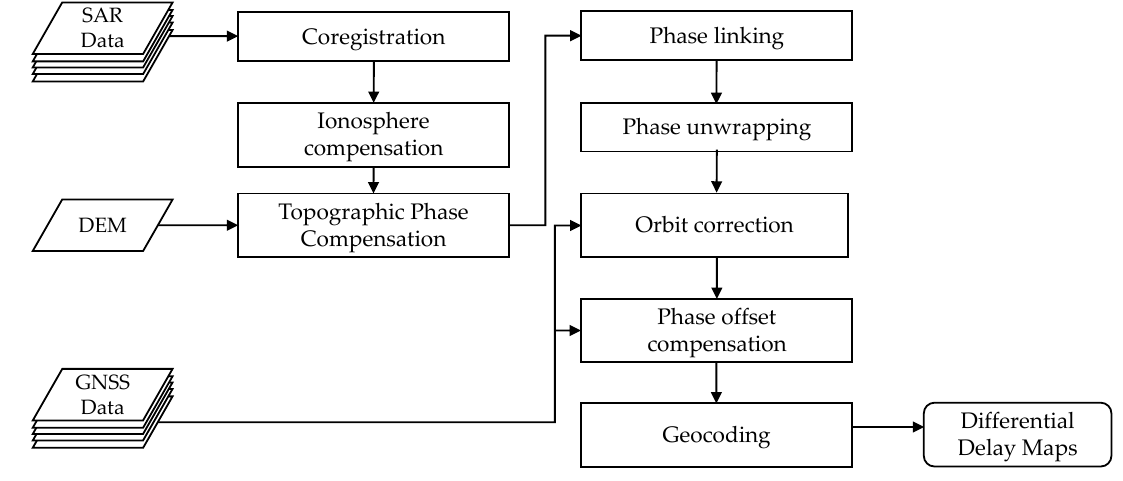
Figure 2. Processing scheme for the extraction of APS maps.